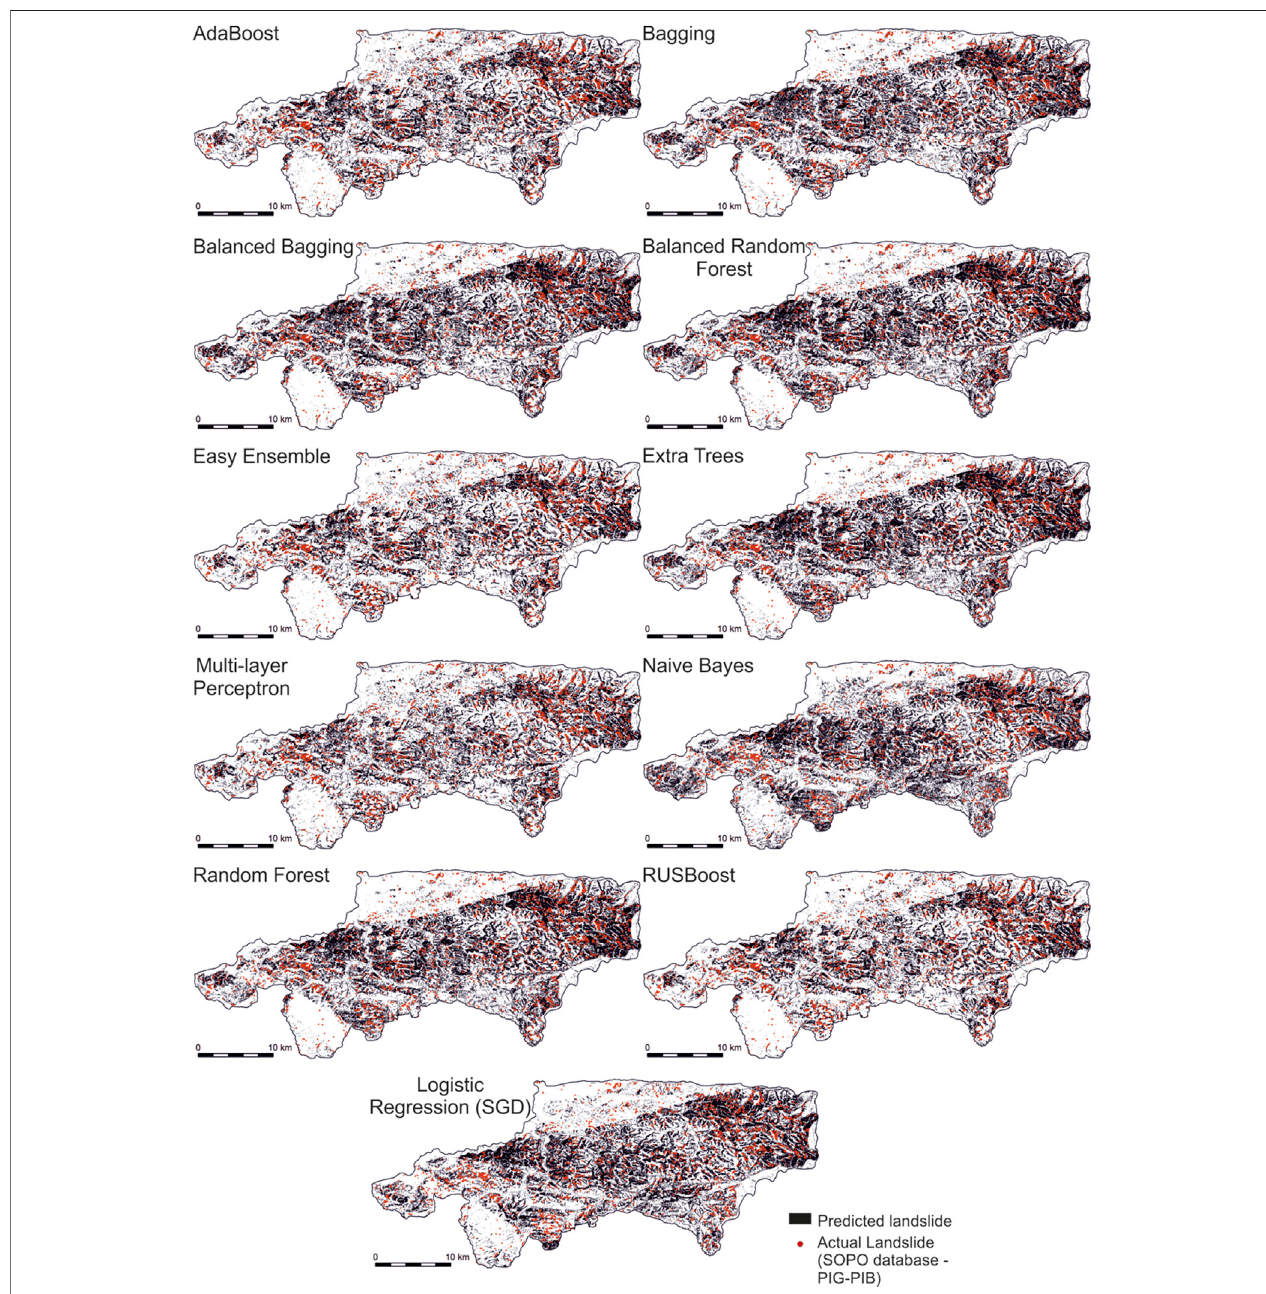
FIGURE 10 | Binary classi fi cation results for the analyzed